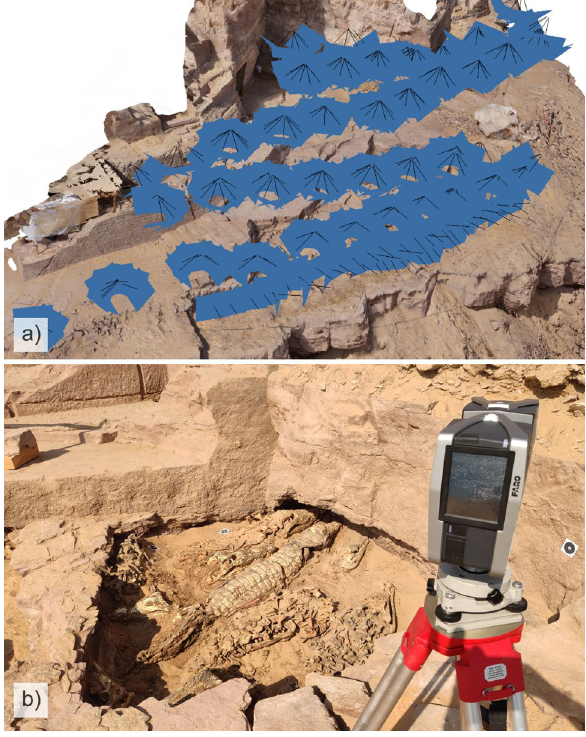
Figure 4. Application: a) Location of photographs (2019); b) Scanning of the QH34ll tomb including crocodile